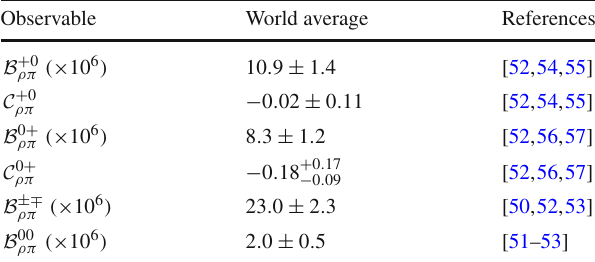
Fig. 9 One-dimensional scan of α in the [ 0 , 180 ] ◦ range from the “Dalitz” SU ( 2 ) isospin analysis of the B 0 → (ρπ) 0 system ( top ) and the “pentagonal” analysis ( bottom ). The interval with a dot indicates the indirect α determination introduced in Eq. (2) Table 8 World averages for the branching fractions B ij ρπ and time- integrated CP asymmetries C ij ρπ for the charged (top) and neutral (bot- tom) B → ρπ decay